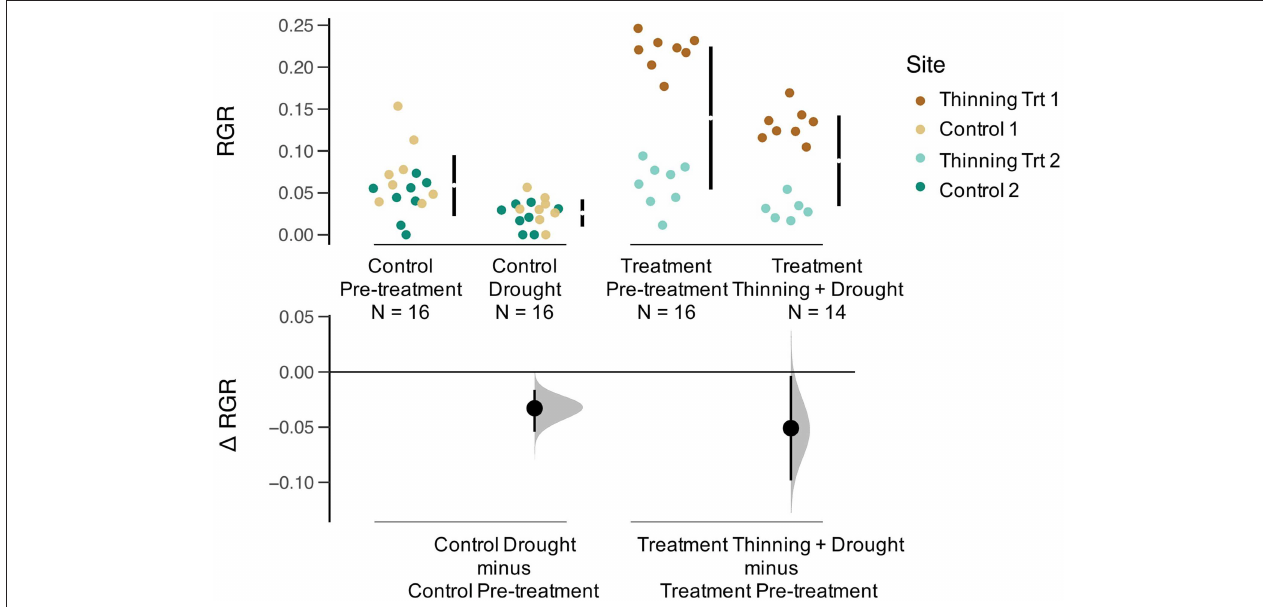
FIGURE 4 | Gardner-Altman plot of relative growth rate (RGR, kg yr − 1 ) for Pre-treatment Control, Drought Control, Pre-treatment, and Thinning + Drought Treatment. Colors represent the four sites. The change in RGR ( 1 RGR, or effect size) is compared between the control and treatment, as well as pre-treatment and drought/drought + thinning